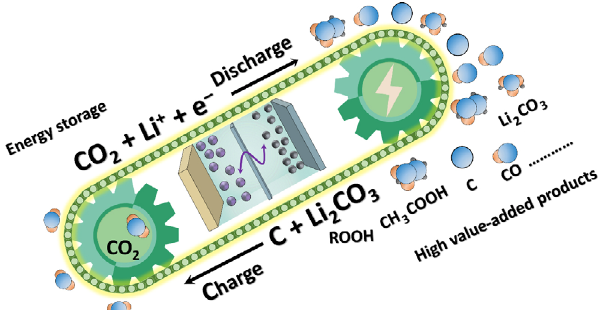
Figure 1 Schematic illustration of the concept of Li–CO 2 batteries toward highlight efficient energy storage and CO 2